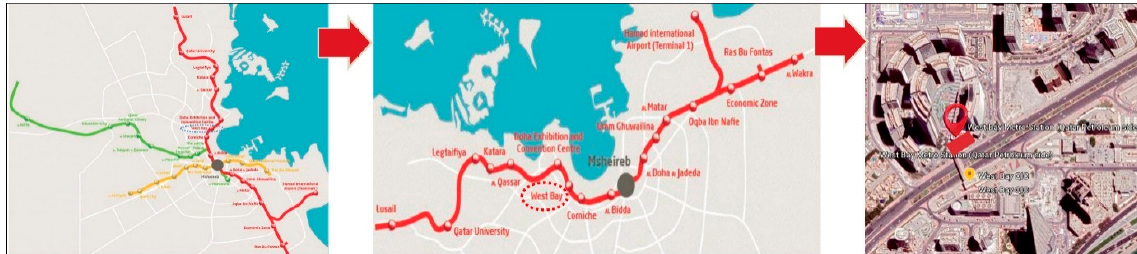
Figure 8. Doha’s metro lines, the metro Red Line, and West Bay metro station (adapted from [5], edited by the Authors).